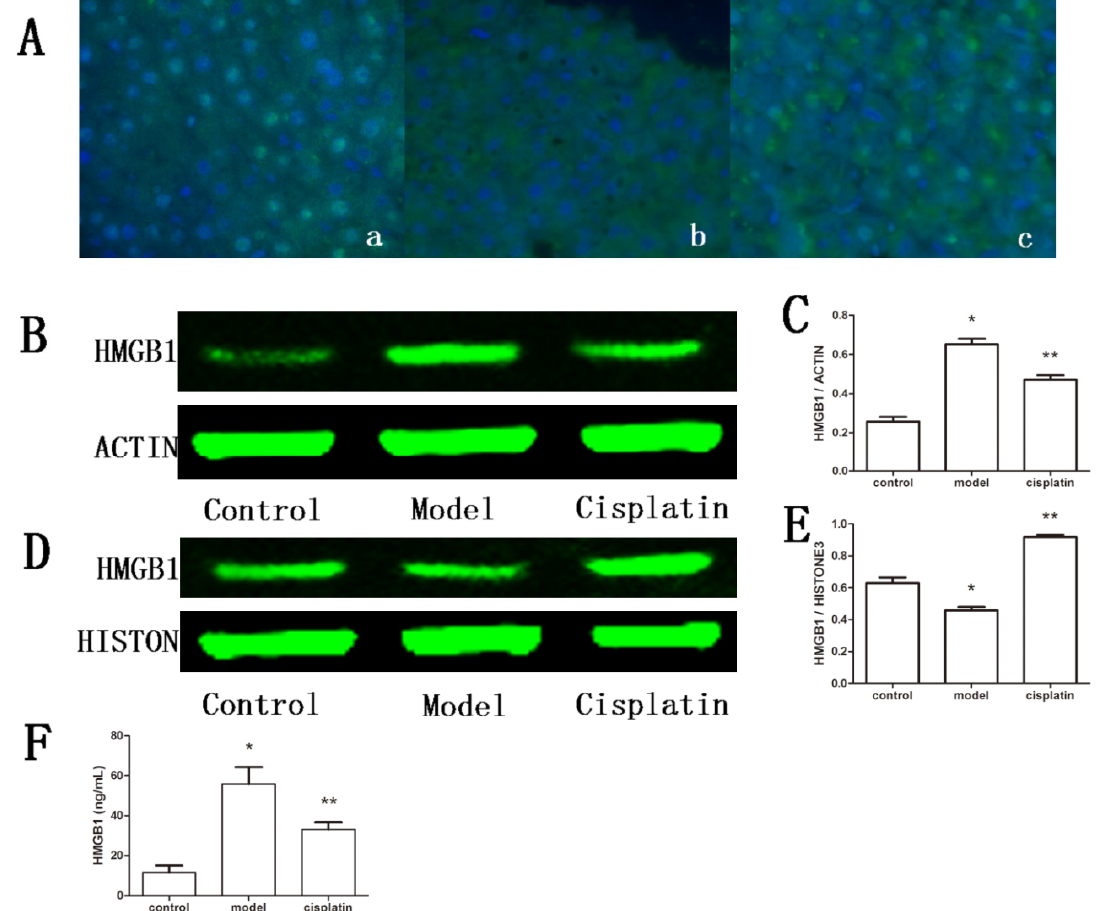
Figure 7. Effect of cisplatin on HMGB1inALF. ( A ) Immunofluorescence staining of HMGB1 in hepatic tissue. HMGB1 was stained green, and nuclei were stained blue, (original magnification ×400). a: Control, HMGB1 (green fluorescence) was observed mainly in nucleus; b: Model group, HMGB1 was observed mainly in the cytoplasm; c: Cisplatin treatment group, HMGB1 was found in the nucleus and cytoplasm; ( B ) Cytoplasmic levels of HMGB1 detected by Western blot analysis. β -actin was probed as an additional loading control. Control: Control group, model: Model group, Cisplatin: Cisplatin treatment group; ( C ) Semi-quantification of cytoplasmic HMGB1 levels. The values for expression are from three independent experiments and are represented as the density of HMGB1 bands normalized to that of β -actin bands. Compared to the control group, * p < 0.05; compared to the model group, ** p < 0.05. Results are expressed as the mean ± SD ( n = 3); ( D ) Nuclear levels of HMGB1 detected by Western blot analysis. Histone3 was probed as an additional loading control. Control: Control group, Model: Model group, Cisplatin: Cisplatin treatment group; ( E ) Semi-quantification of nuclear HMGB1 levels. The values of relative protein expression levels are from three independent experiments and are represented as the density of HMGB1bands normalized to Histone3 bands. Compared to the control group, * p < 0.05; compared to the model group, ** p < 0.05. Results are expressed as the mean ± SD ( n = 3); ( F ) Serum levels of HMGB1. Control: Control group, model: Model group, cisplatin: Cisplatin treatment group. Results are expressed as the mean ± SD ( n =